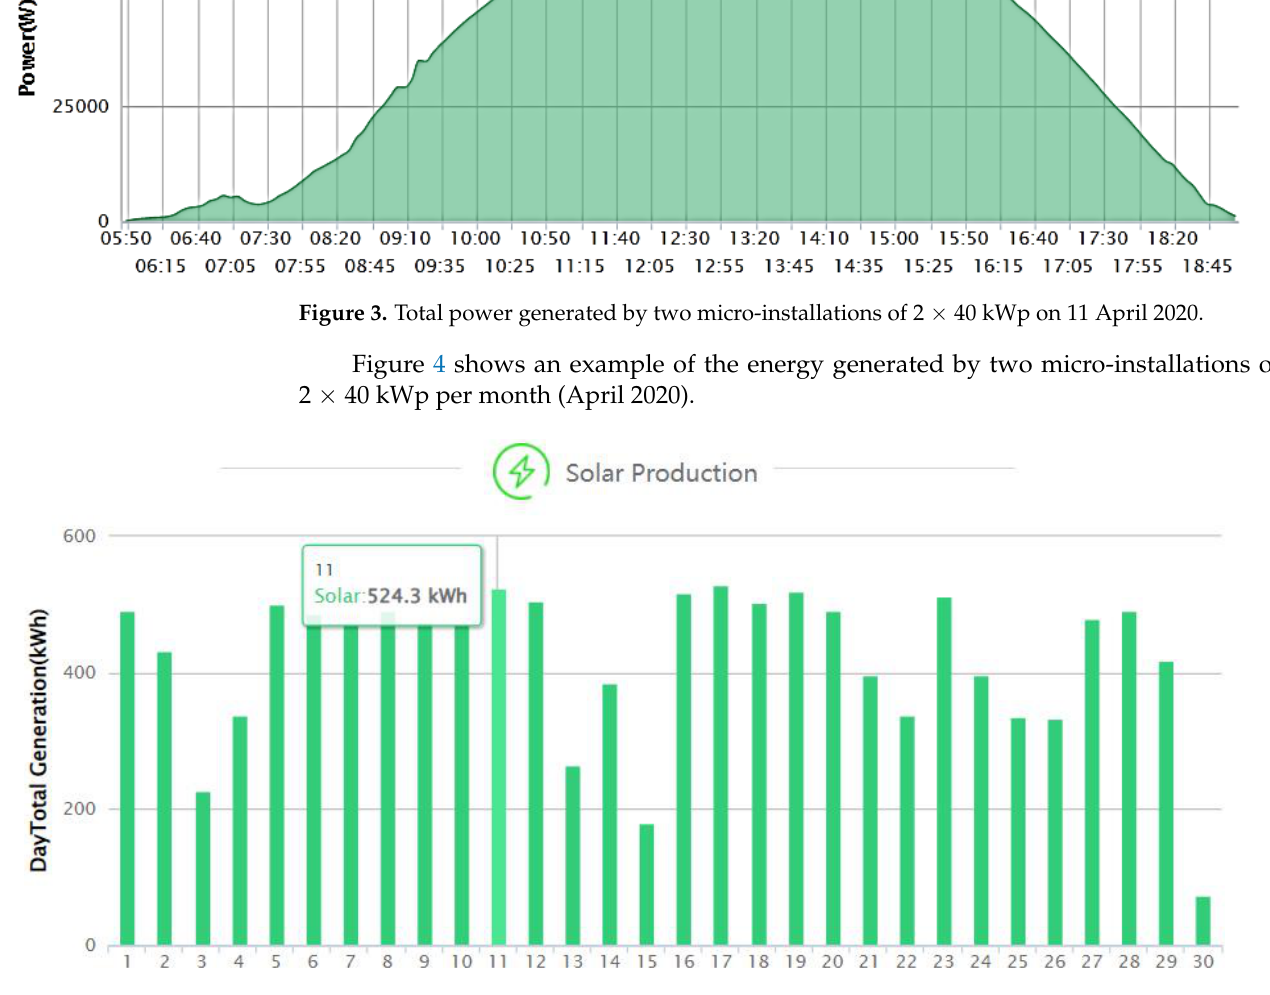
Figure 4. Total power generated by two micro-installations of 2 × 40 kWp per month (April 2020).